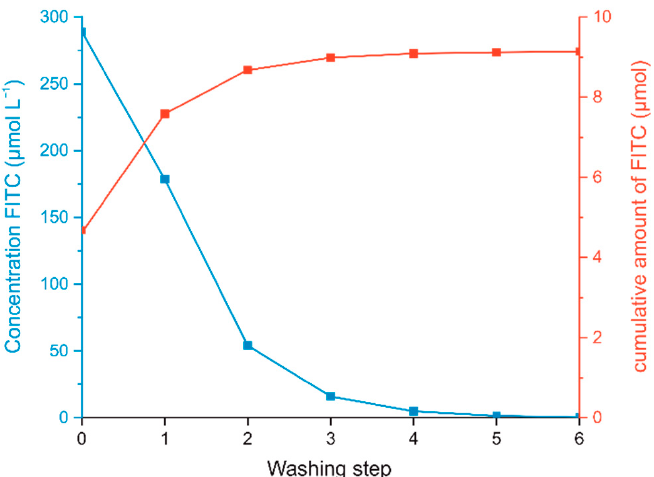
Figure 2. Stepwise washing of CNC-APTES-FITC-3 with bicarbonate buffer: FITC concentration in supernatant of each washing step (blue); removed molar amount of FITC from precipitate (cumulative, red).